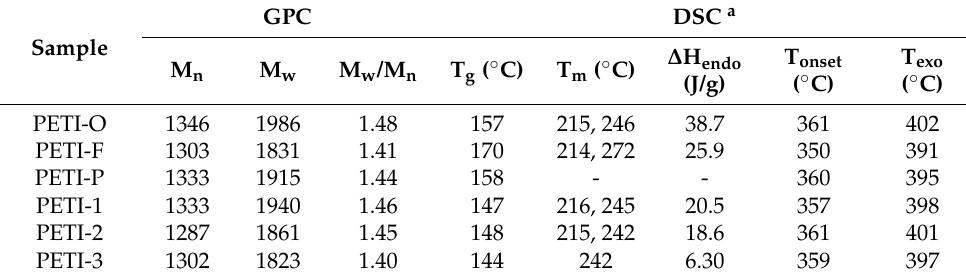
Table 1. Physical properties of uncured oligoimides.